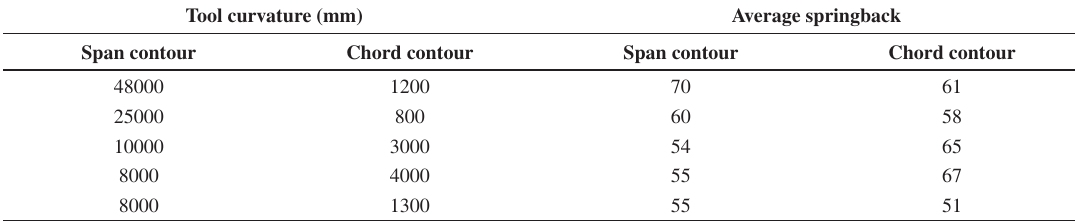
Table 6. Results of the forming tests - adapted from 17 .